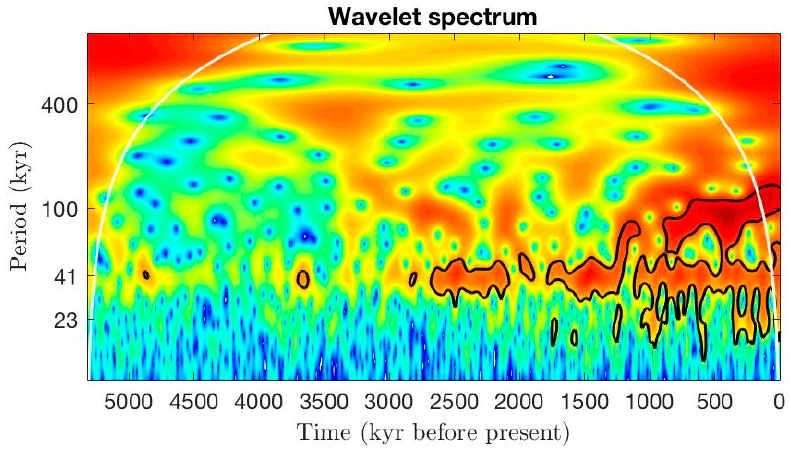
Figure 3. Wavelet transform (WT) scalogram of temperature data of Figure 1 obtained by using an analytical Morlet WT mother function with parameter 6.